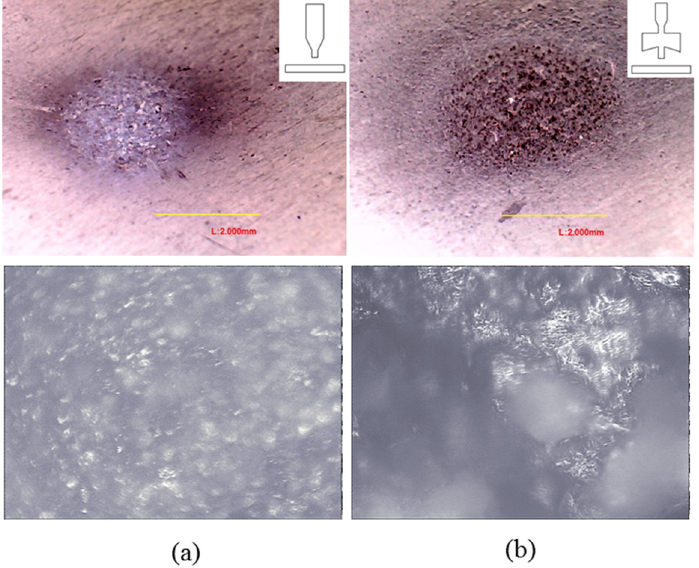
Figure 10. Comparison of erosion results between conical nozzle and HSEOW nozzle. ( a ) Conical nozzle (400-times magnification); ( b ) HSEOW nozzle (400-times